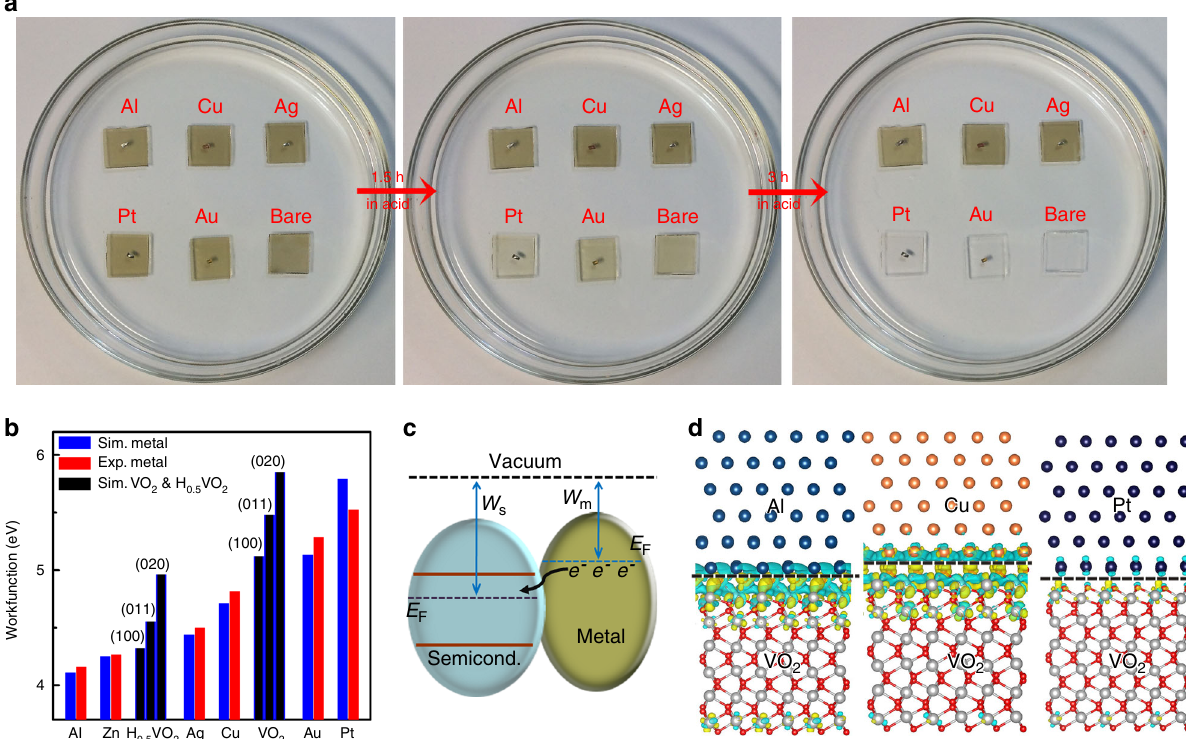
Fig. 3 Hydrogenation effects induced by different metals. a Metals, such as Al, Cu, Ag, can protect M-VO 2 (1 cm × 1 cm size) from corrosion in 2%wt H 2 SO 4 acid solution, whereas metals, Pt and Au, can not. b Computed and experimental workfunction ( W F ) values for metals, VO 2 , and lightly hydrogenated H 0.5 VO 2 , with the order of Pt > Au > VO 2 > Cu > Ag > H 0.5 VO 2 > Zn > Al. c Schematic depiction of electrons fl owing from metal with a higher Fermi level (i.e., lower workfunction W m ) to semiconductor with a lower Fermi level (i.e., higher workfunction W s ) at the interface. d Computed differential charge distribution at Al/Cu/Pt – VO 2 (020) interfaces, showing that active metals (Al and Cu) donate effective electrons to VO 2 . Green and yellow bubbles represent hole and electron charges, respectively. Gray, red, cyan, brown, navy beads stand for V, O, Al, Cu, Pt atoms,